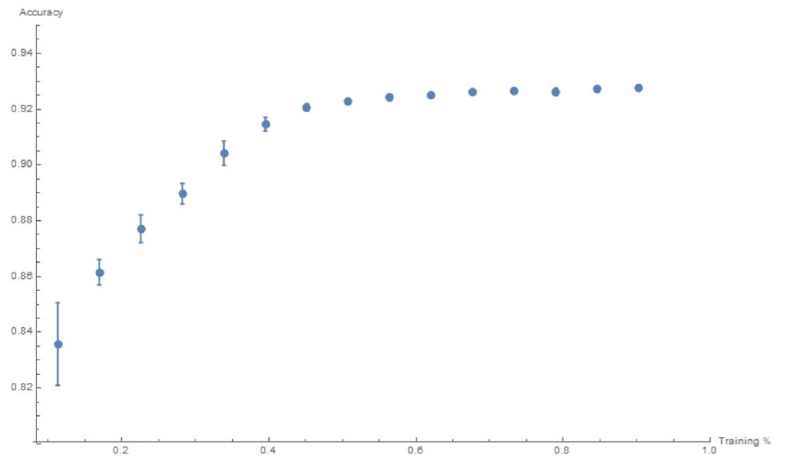
Fig 4. Learning curve for the R-square value versus fraction (seen) training data from 0 to 1.